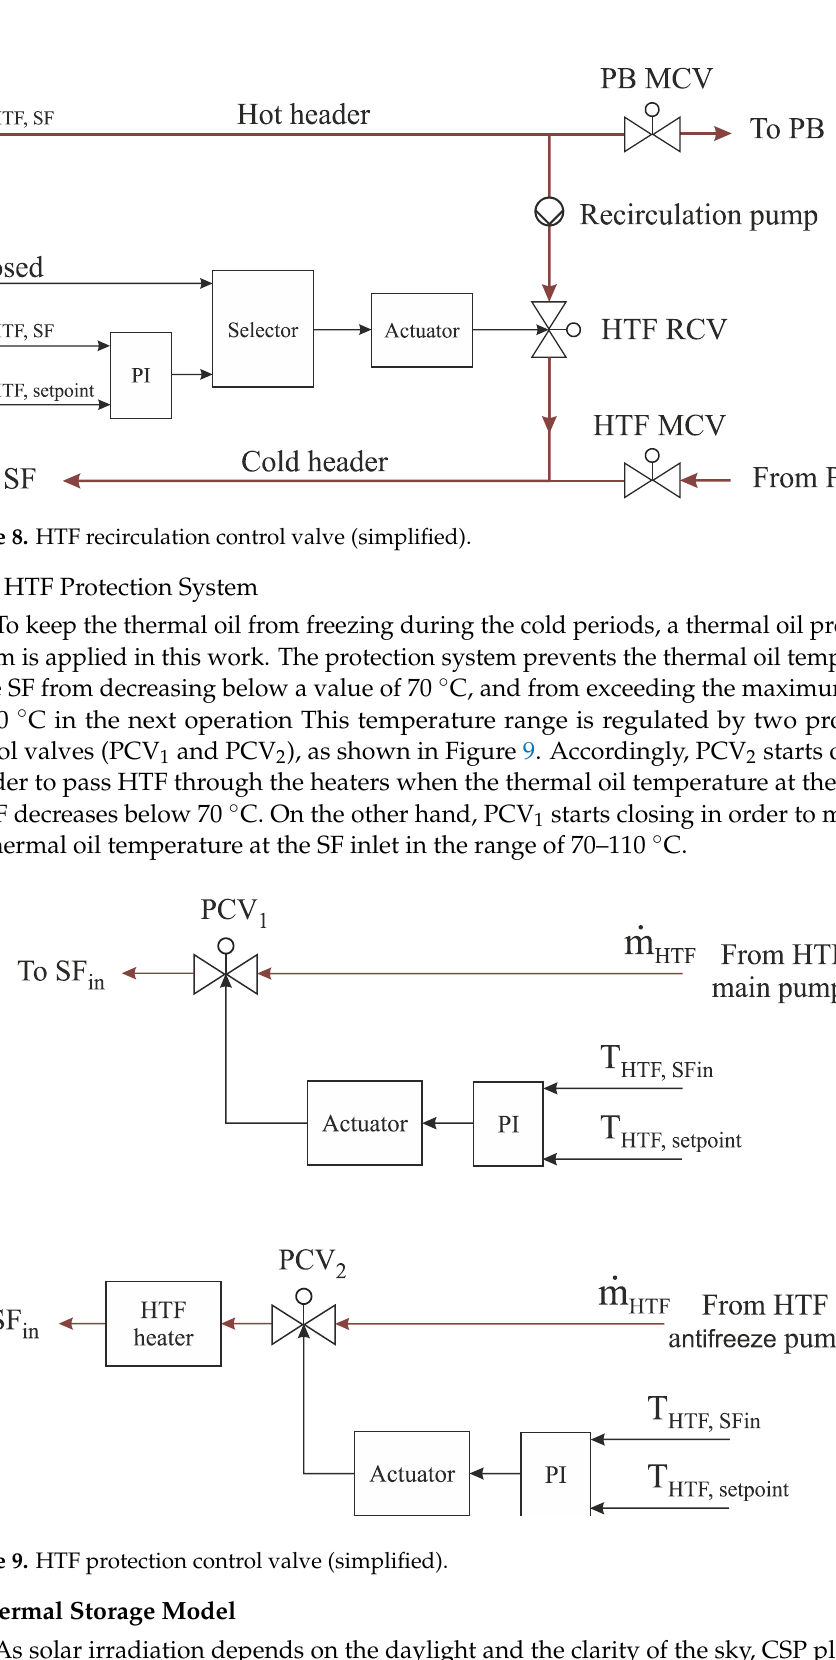
8 of 14 . Figure 7. HTF redirection control valve (simplified). 3.1.6. HTF Recirculation Control Valve (RCV) The HTF recirculation valve (RCV) is installed between the hot header and the cold